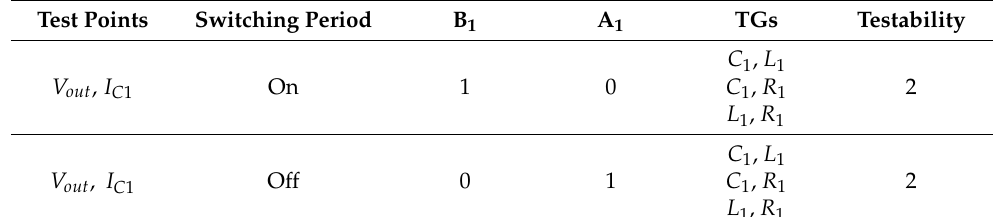
Table 1. Testability analysis in the frequency domain for a buck converter.